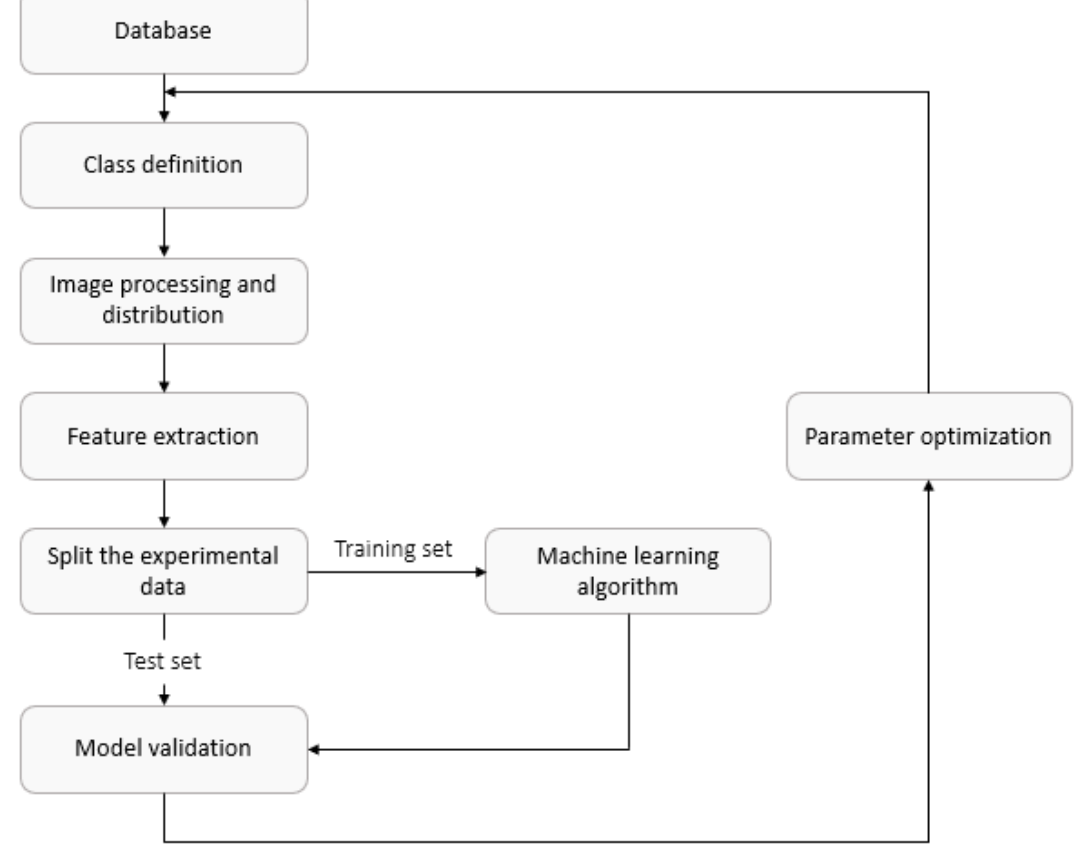
Figure 3. Data processing and model training.